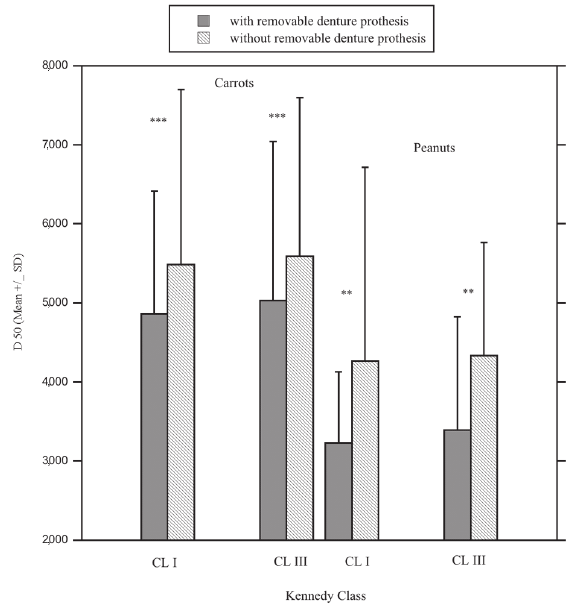
Figure 1- Mean variation ± standard deviation of the granulometry of the carrot and peanut preswallowed bolus (D50, median size of bolus particle) whether a removable prosthesis was worn or not, and according to the type of edentulous areas. Repeated measure procedure was used for intergroup comparisons (***p<0.001,